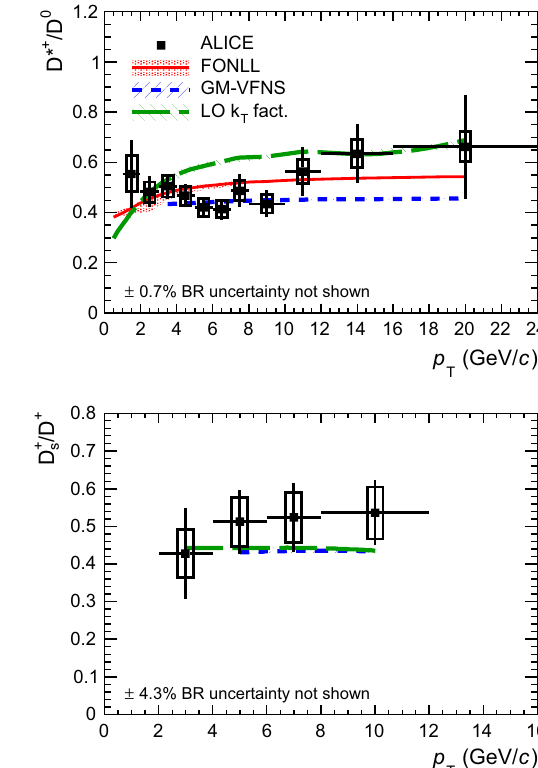
ratio of the central values of the theoretical cross sections, while the shaded area is defined by the ratios computed from the upper and lower limits of the theoretical uncertainty band